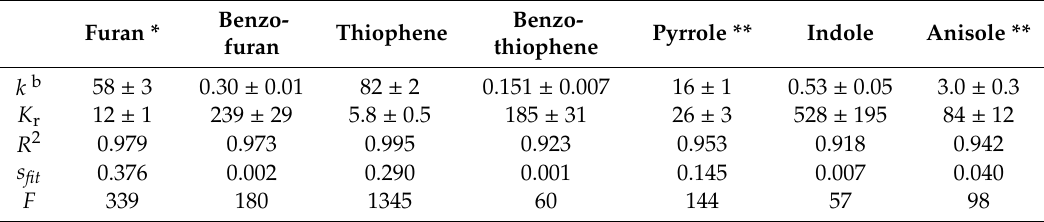
Table 3. Rate constants, k , and relative sorption equilibrium constants, K r , of the BEA-D catalytic reactions. Shown also are the fits’ statistical figures of merit a .